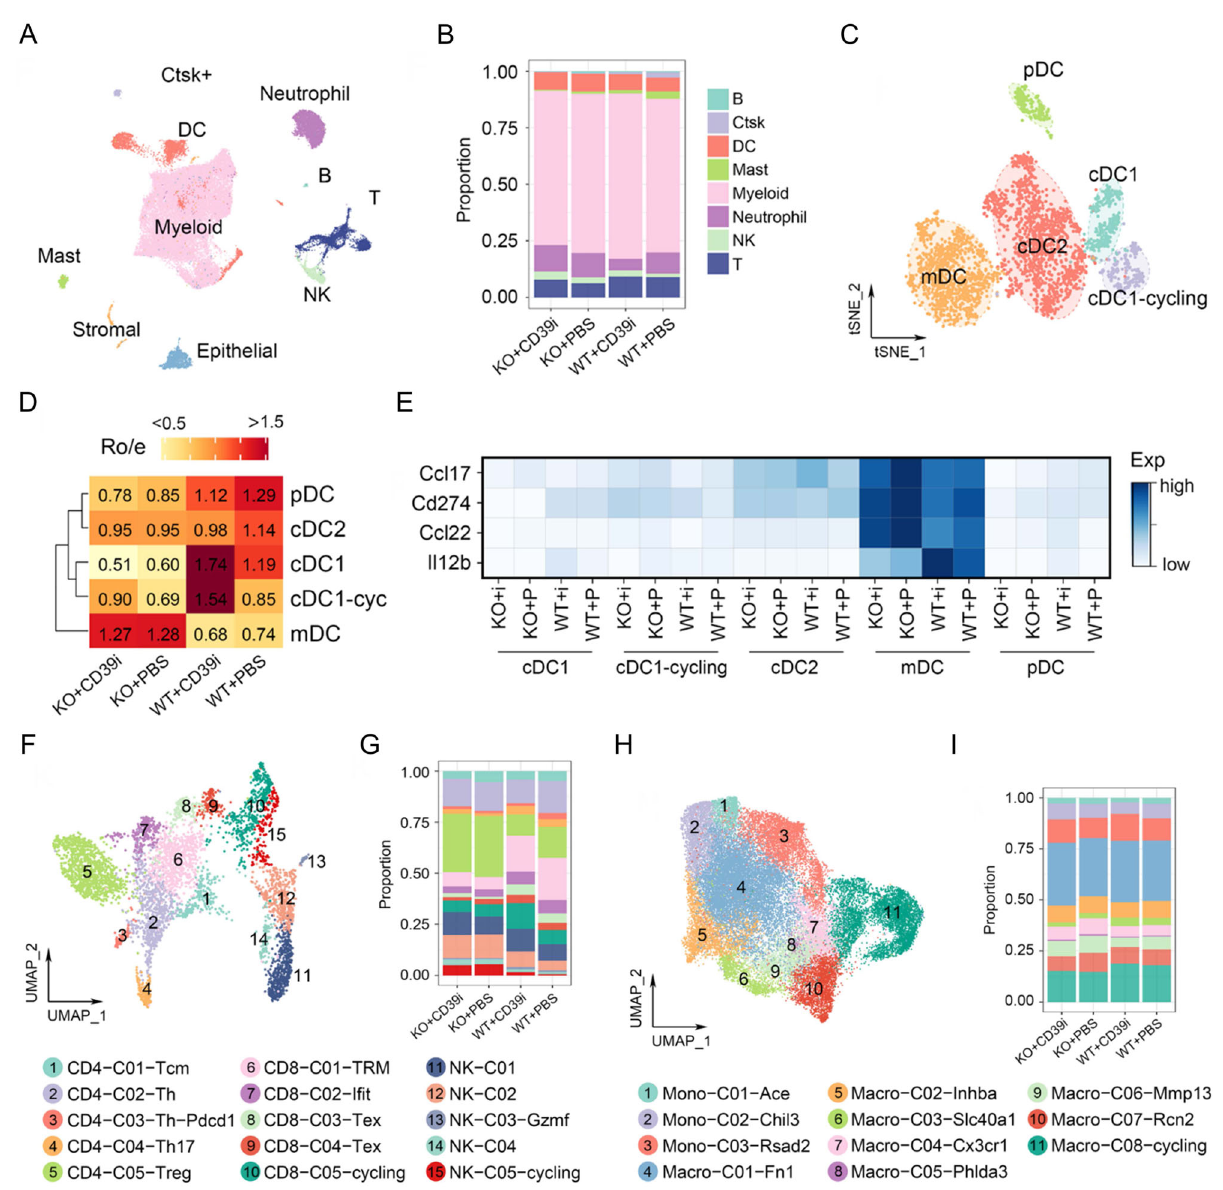
Fig. 6 | The effects of Batf3 − / − cDC1-de fi cient on tumor microenvironment and CD39ief fi cacy.A SinglecellsfromWTand Batf3 − / − cDC1-de fi cientmicetreatedwith or without CD39i were clustered into 10 major clusters, 3 subcutaneous tumors from 3 mice in each group mixed 1:1:1. B The proportions of 8 major clusters without stromal cells and epithelial cells. C The DCs were clustered into 5 clusters based on classical markers. D Ratios of observed to expected cell numbers (Ro/e) foreachDCsubclusterindifferentgroups,Ro/e>1.1wasconsideredasenrichedin